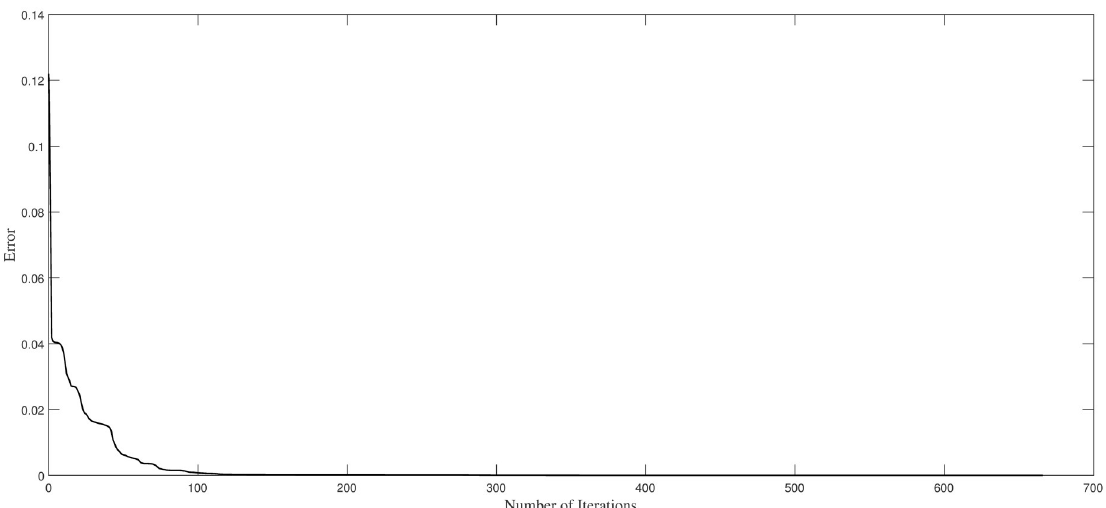
Fig 11. Trend of training errors with iteration steps in Example